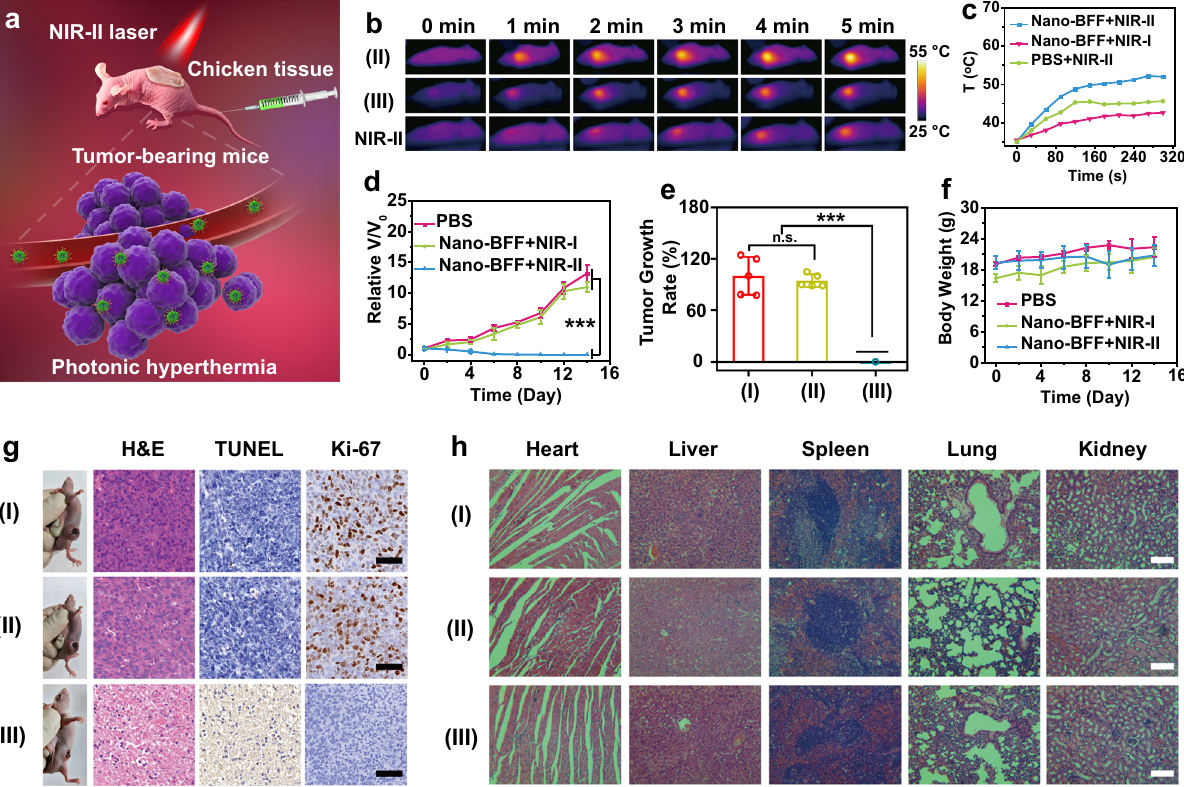
Fig. 6 In vivo deep-tissue photonic tumor hyperthermia of Nano-BFF in the NIR-II biowindow. a Schematic interpretation of deep-tissue photonic cancer hyperthermia using Nano-BFF. b Thermal images, and c temperature pro fi les at tumor regions of tumor-bearing mice in different treatment groups after the penetration through 4 mm of chicken breast tissue ( n = 5 biologically independent samples). d Relative tumor volumes, e tumor growth rates, and f body weight variations of the mice in varied treatment groups ( n = 5 biologically independent samples). Data are presented as mean values ± SD. n.s.: not signi fi cant. p > 0.05; * p < 0.05; ** p < 0.01; *** p < 0.001, analyzed by Student ’ s two-sided test. g Representative photographs of mice and corresponding H&E, TUNEL, and Ki-67 antibody staining of the tumor tissues after various treatments (scale bars: 50 μ m). h H&E staining of main organs from varied treatment groups (I: PBS; II: Nano-BFF + NIR-I laser; III: Nano-BFF + NIR-II laser, penetration depth: 4 mm). Scale bars: 100 μ m. A representative image of three biological replicates from each group is